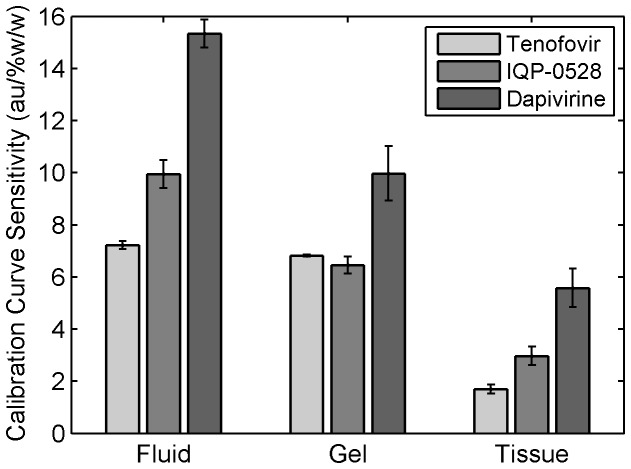
Calibration sensitivity for detection of Tenofovir, IQP-0528 and Dapivirine in fluid, clinical gel and tissue.The slopes, i.e. the incremental changes in intensity per change in concentration, of the linear dilution response curves represent the sensitivities of measurement. Response differences were observed for the three drugs in the different matrices. A significant difference in sensitivities among the drugs was observed (P<0.0001, two-way ANOVA with Fisher’s PLSD), and these relative sensitivities of drugs were dependent on the matrix in which they were measured (drug*matrix interaction, P <0.01). Fluids gave higher sensitivities than other matrices due to less background scattering. Dapivirine tended to have higher sensitivity than other microbicide drugs. The data shown represent the mean ± standard error of 3-4 replicates.